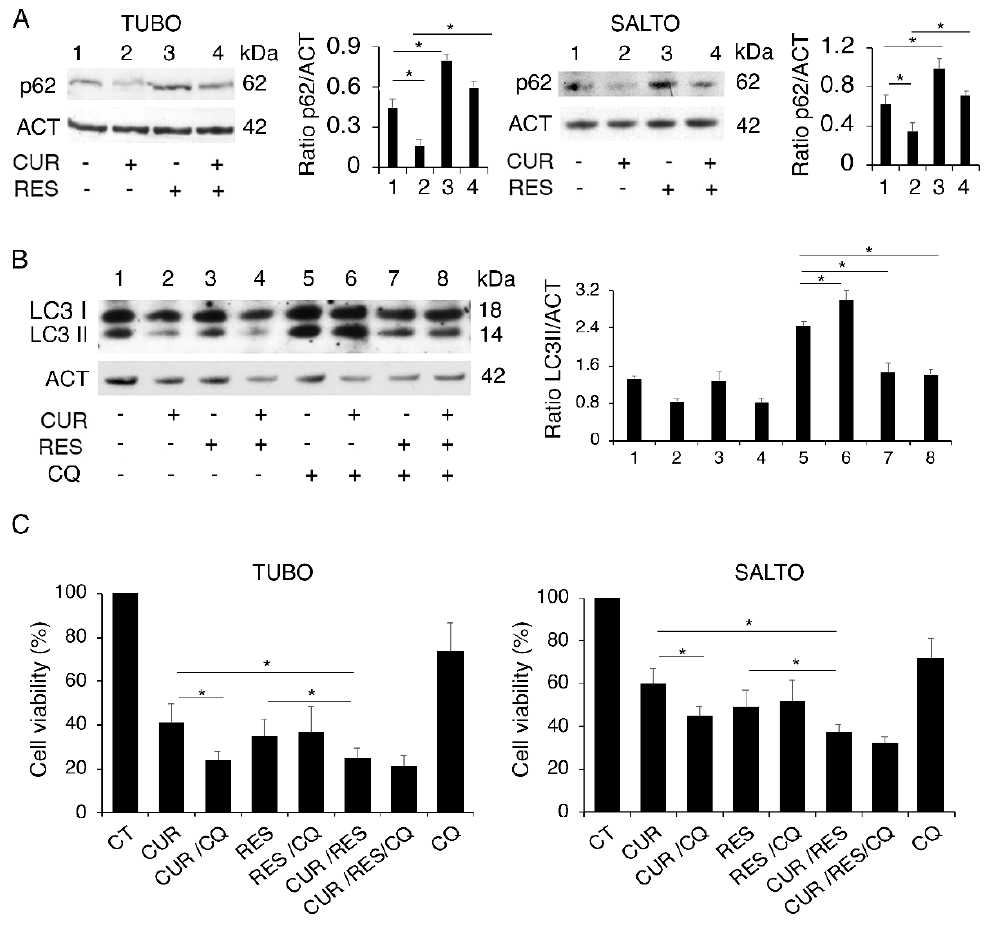
Figure 2. Curcumin promotes autophagy while resveratrol reduces this process also in combination with curcumin. ( A ) p62 expression level in TUBO in SALTO cells untreated or treated with curcumin, resveratrol or combination of both, at the above reported concentrations, for 48 h, as assessed by Western blot analysis. ( B ) LC3I/II expression was evaluated in TUBO cells treated by curcumin, resveratrol or combination of both in the absence or in the presence of chloroquine (10 µ M) added for the last 10 h. One representative experiment is shown. Histograms represent the mean plus standard deviation of densitometric analysis of three independent experiments. Actin was used as a loading control. ( C ) Cell survival as evaluated by trypan blue assay in cells treated by curcumin, resveratrol or combination of both in the absence or in the presence of chloroquine. Histograms represent the mean plus standard deviation of three independent experiments. * p value <0.05.